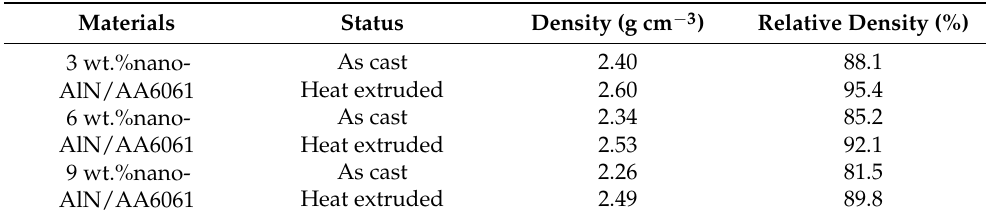
Figure 3. SEM images of ( a ) AA6061 flakes prepared after ball milling ‐ 1; ( b , c ) Nano ‐ AlN/AA6061 flakes prepared after ball milling ‐ 2. Table 2. Density and relative density of nano-AlN composites of as-cast and HE.